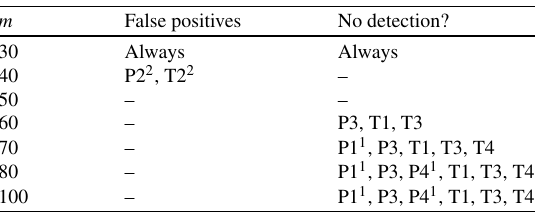
Table 1 Influence of parameter m in perturbation detection performance